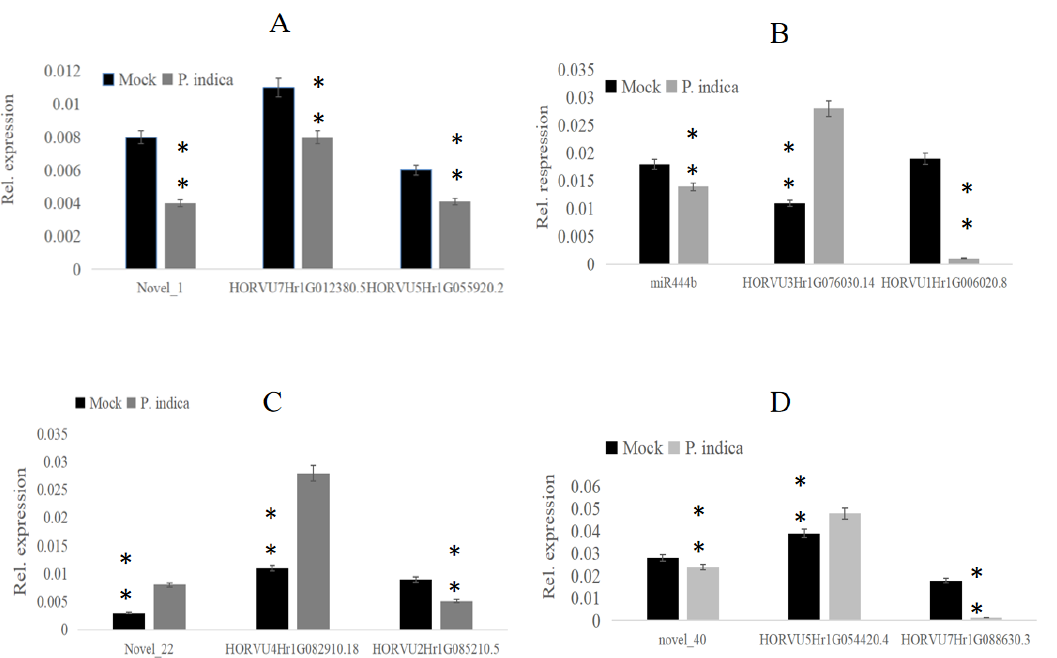
Figure 6. Go enrichment histogram of differentially expressed genes (DEGs) in barley. ( A ) GO enrichment in 3 dai vs. mock; ( B ) GO enrichment in 7 dai vs. mock. ( C ) GO enrichment in 7 dai vs. 3 dai. The abscissa denotes the name of GO entry, which is divided into three categories by box: BP: biological process, CC: cell component, MF: molecular function, distinguished by different frames, and the ordinate is the number of genes enriched by GO entry. ( D ) The chart shows that miRNA_novel 40 was downregulated and its target genes HORVU5Hr1G054420.4 was upregulated; another target gene HORVU7Hr1G088630 was downregulated. The experiments of q-PCR and the data analyses were performed in three biological replicates. * Significant difference ( p < 0.05); ** Highly significant difference ( p < 0.01). Table 5. Functions of target mRNA corresponding to down-regulated miRNA in 3 dai vs. mock. miRNA Target